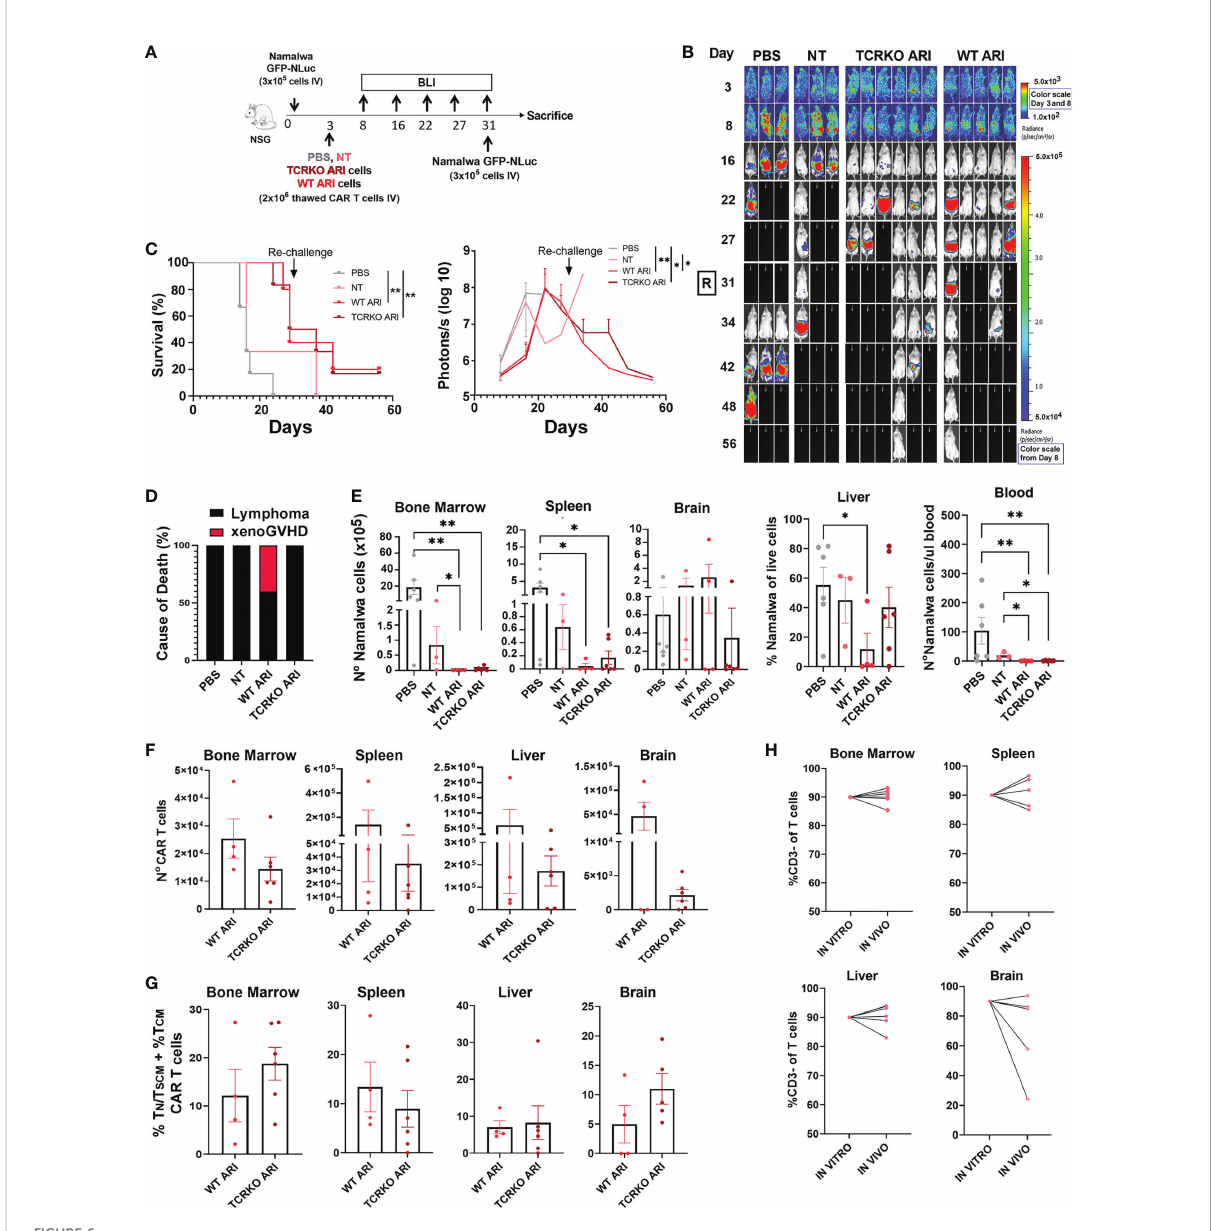
FIGURE 6 In vivo anti-tumor activity and phenotype of TCRKO ARI-0001 cells. (A) Schematic overview of the in vivo experimental design. (B) Representative BLI images of tumor burden at different days after Namalwa inoculation. A rechallange with new Namalwa cells was performed with alive mice at day 31. Color scale bar is shown for Day 3 and Day 8-56. Radiance scale is shown in each bar. (C) Left: Overall survival. Mice with > 20% body weight loss or high bioluminescence signal (>5x10 7 Photons/sec) were sacri fi ed (N=3 mice for untreated (PBS) and non- transduced (NT), N=5 mice for WT ARI-0001 and N=6 mice for TCRKO ARI-0001. CAR T cells were obtained from one healthy donor. Right: radiance quantitative trace of each group of mice represented as photons per second at the different days. (D) Incidence (%) of lymphoma- or xenoGVHD- related death in the different mouse groups. (E) Number of Namalwa cells in bone marrow, spleen, liver, brain and blood in NSG mice left untreated (PBS) or treated with NT, ARI-0001 CAR-T cells (WT ARI) and TCR-de fi cient ARI-0001 cells (TCRKO ARI) at the end point. (F) Number of CAR-T cells in bone marrow, spleen, liver and brain in NSG mice treated with WT ARI-0001 or TCRKO ARI-0001 cells at the point. G ) Percentage of T N /T SCM +T CM population in hCD2+CAR+ cells analyzed in different mice organs after sacri fi ce. Only when CAR+ population was >1%, data was included. (H) Percentage of hCD3- cells of live cells prior inoculation ( in vitro ) and %hCD3- cells of hCD2+ cells in liver, bone marrow, spleen and brain after sacri fi ce ( in vivo ). Statistics are based on log rank test (C) , unpaired, one-tailed Student´s t-test (D) , *p<0.05, **p<0.01. Graphs show mean ±